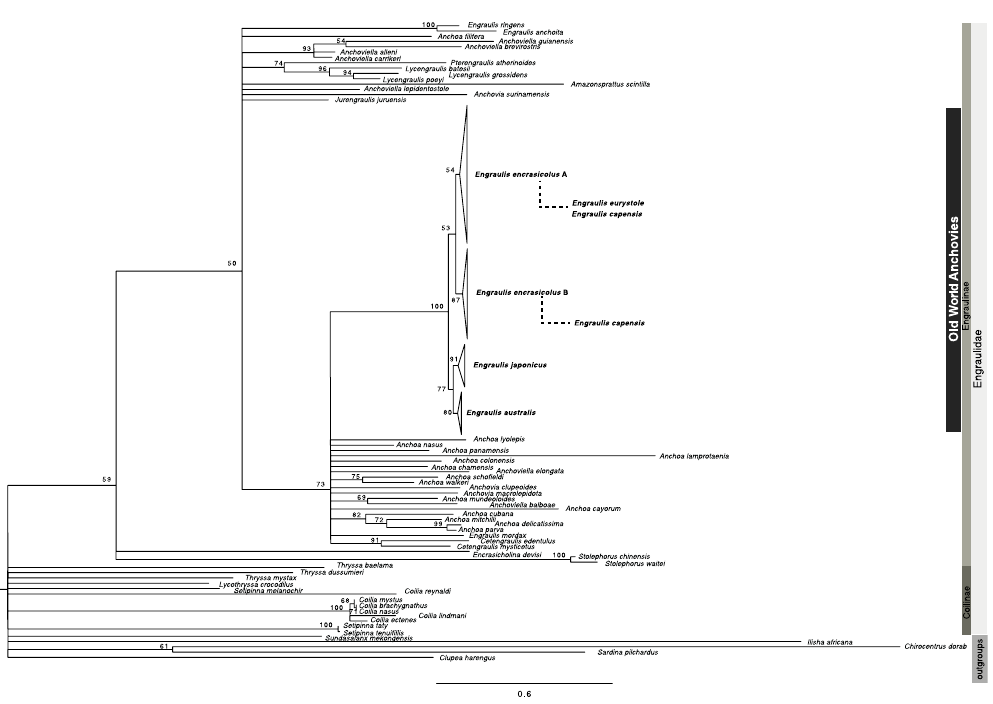
Figure 4. Phylogenetic relationships of Old World Anchovies Engraulis spp . maximum likelihood analyses inferred from a fragment of 1044 bp of cyt b . Maximum likelihood bootstrap values for major supported clades larger 50% are shown above